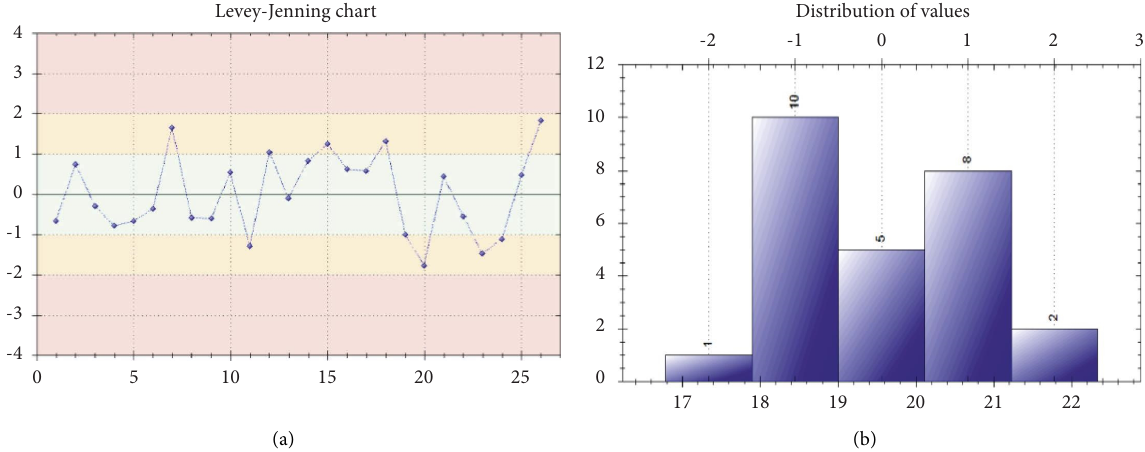
Figure 1: Levey–Jenning chart (a) and distribution of values (b) of intermediate precision test results of MAScIR SARS-CoV-2 kit M 2.0. (target RdRp, QS5 thermal cycler). Table 2: Analytical specifcity test result of the MAScIR SARS-CoV-2 M 2.0 kit.